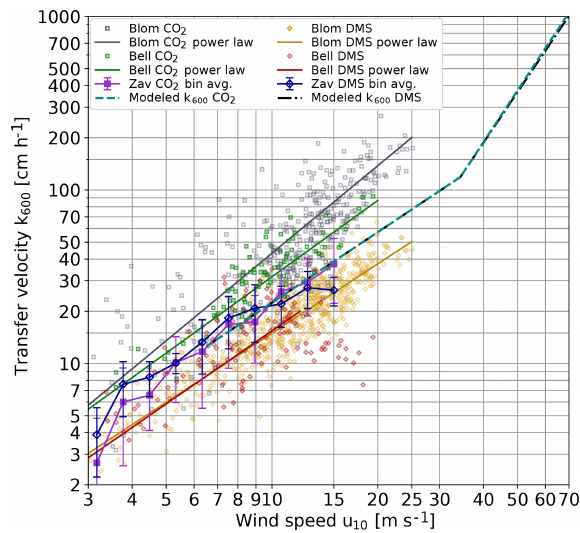
Figure 8. Ratio of k c , 600 to k s , 600 , i.e., the bubble-induced gas transfer velocity in the limit of low solubility to the gas transfer velocity at the free surface in relation to the friction velocity, given in percent of the gas transfer velocity at the free surface.